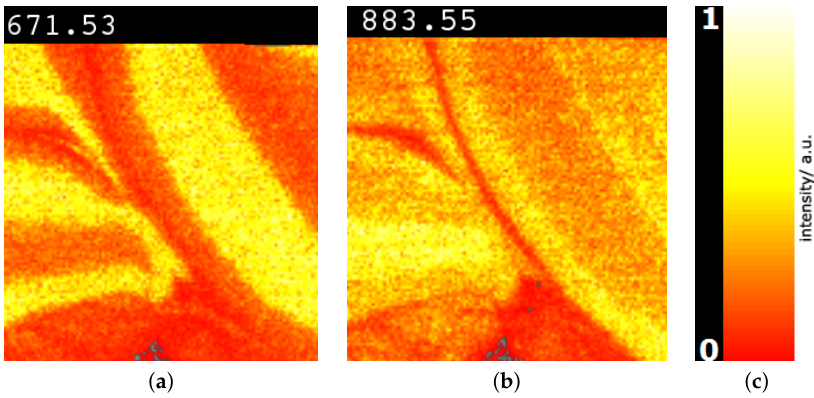
Figure 9. Juxtaposed boxplot visualization for discriminant peaks selected in Figure 8 allows for quantitative comparative analyses of peak intensity distributions between selected image regions. Computed p -values for each peak are reported after its m / z -ratio in the labels of the horizontal axis.